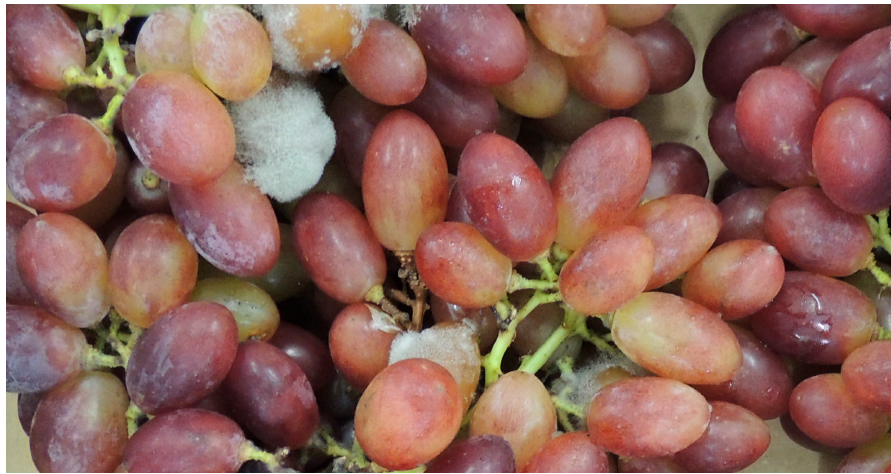
Figure 1. ‘BRS Isis’ seedless table grape bunches presenting typical gray mold ( Botrytis cinerea ) symptoms.